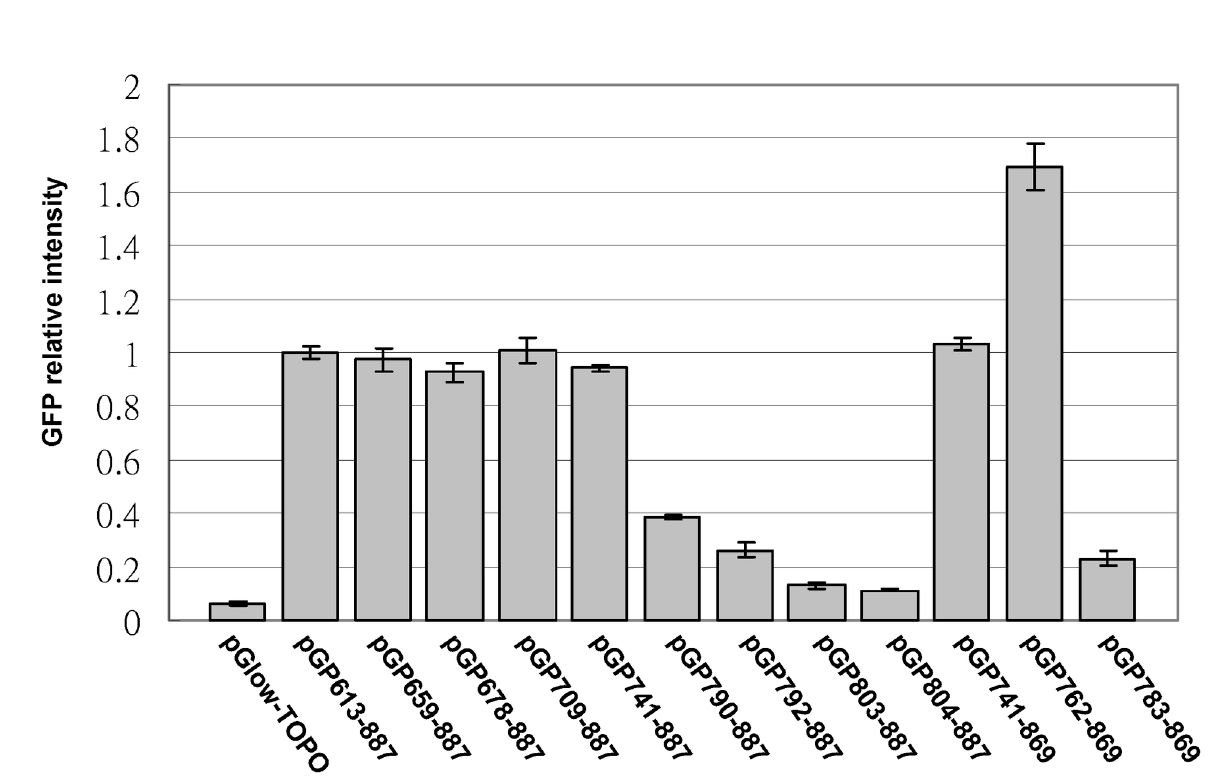
Figure 2. Fine mapping of the essential AV3 promoter region. Bar chart representation of the quantification of GFP fluorescence intensities of various constructs. The average fluorescence intensities of four replicates from pGP613-887 were used as the basis for comparison, with those from other constructs expressed as relative fold changes (Y axis). The identities of the constructs are indicated at the bottom of each bar. The error bars indicate standard deviations calculated from at least four